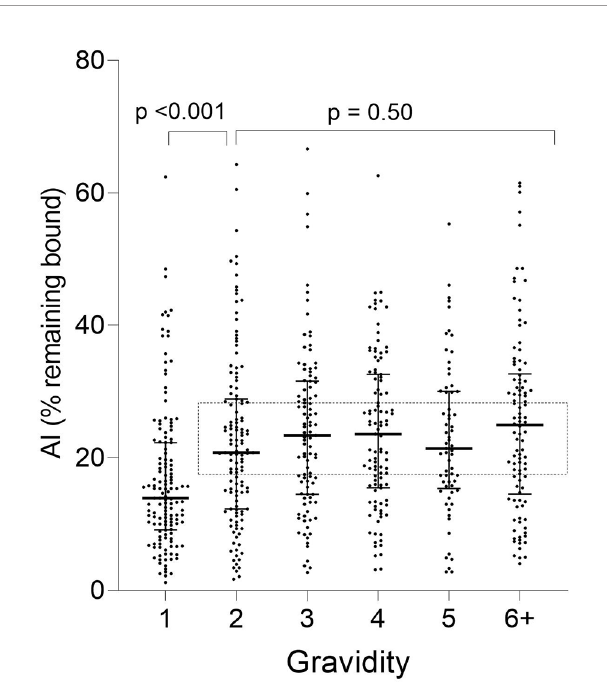
FIGURE 2 | Antibodies to FV2 at delivery in PM − and PM+ women. Antibody levels were signi fi cantly lower in PM − primigravidae (G1) than G2 (Mann- Whitney test: p < 0.001), but no signi fi cant difference was found among the gravidity groups shown in the rectangle (Kruskal-Wallis test: p = 0.80). n = 644 women. Horizontal lines represent medians and IQR.